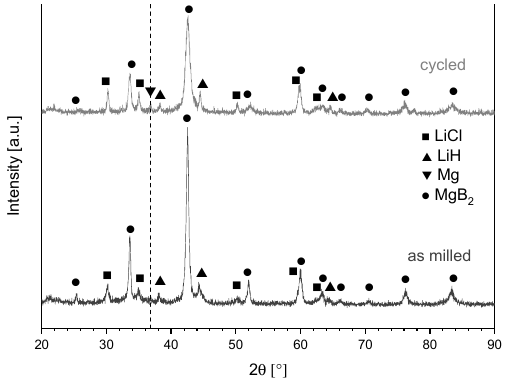
Figure 9. XRD patterns for the 2 LiH + MgB 2 + 0.025 TiCl 3 composite milled for 30 h at 330 rpm with 50% of filling and a BPR of 5:1 before (as milled) and after 2 cycles (cycled). Adapted from Reference [30], with author’s permission.